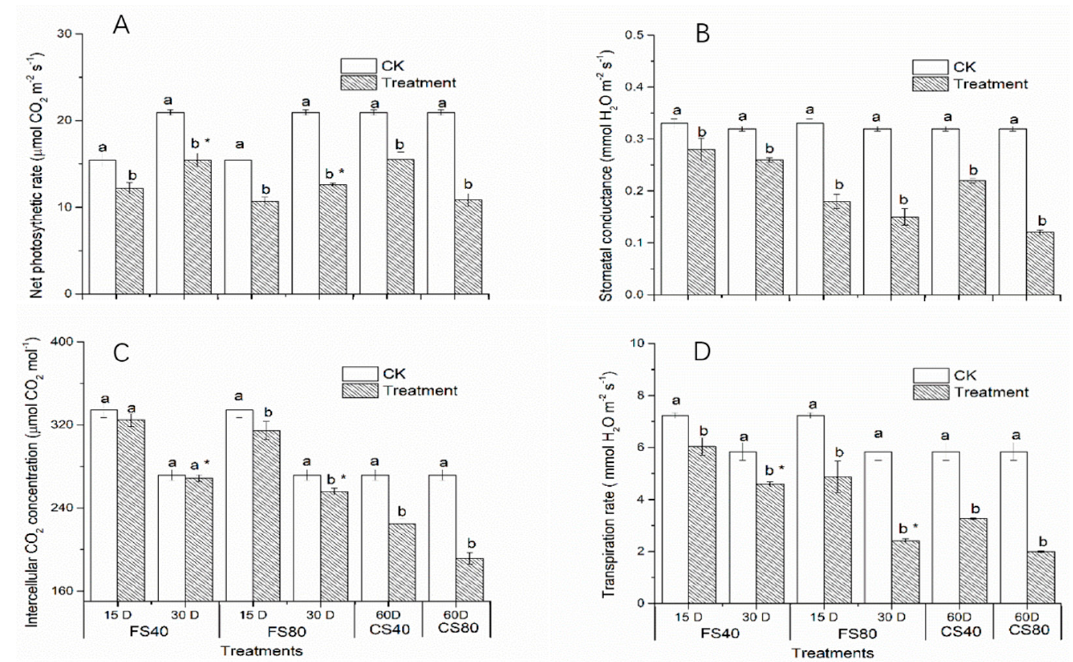
Figure 7. E ff ects of shade stress on photosynthesis parameters in peanut leaves. ( A ). Changes in net photosynthetic rate, ( B ). Changes in stomatal conductance, ( C ). Changes in intercellular CO 2 concentration, ( D ). Changes in transpiration rate. Data represent mean ± standard error. The measurement was conducted on leaves on the main stem after a treatment. Letters a and b after the value represent the statistically significant di ff erence ( p < 0.05) between any two conditions within a stage as determined by the Least Significant Di ff erence test. * represents a significant di ff erence at p < 0.05 between di ff erent treating durations of 15 days and 30 days. FS40, FS80, CS40, and CS80 represent shade treatments of 40% shade at the flowering stage for 30 days, 80% shade at the flowering stage for 30 days, 40% shade from the seeding stage for 30 days to the flowering stage for another 30 days, 80% shade from the seeding stage for 30 days to the flowering stage for another 30 days, respectively. Three experiments were conducted, each with three plants. CK represents control under natural light.